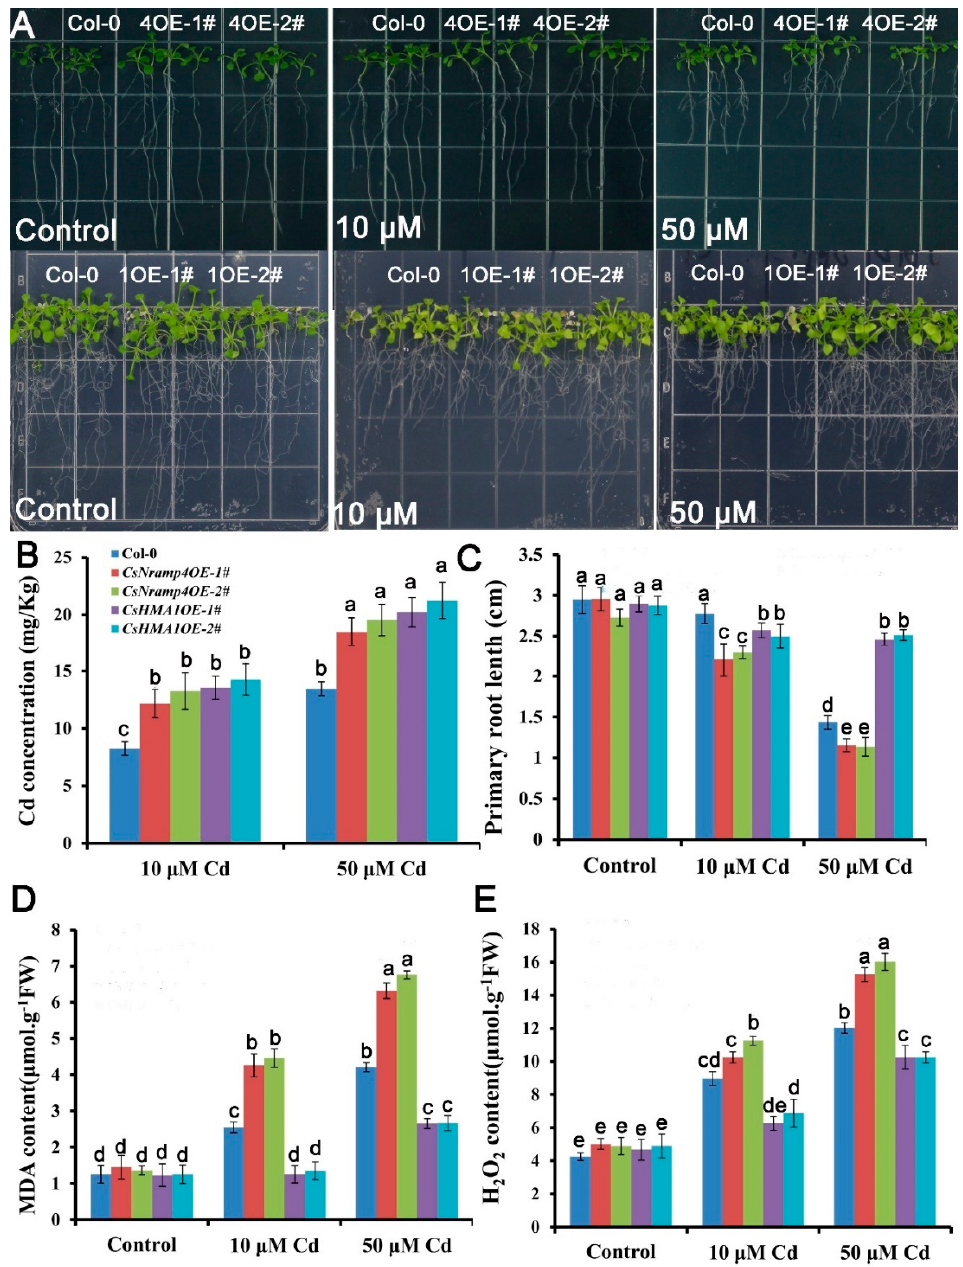
Figure 8. Analysis of Cd tolerance in the wild type (WT), CsNramp4 transgenic lines ( UBI10:CsNramp4 ), and CsHMA1 transgenic lines ( UBI10:CsHMA1 ) of Arabidopsis. ( A ) Phenotype of seedlings grown on 1/2 MS medium with or without 10 or 50 µ M Cd for 12 d. ( B ) Primary root length of UBI10:CsNramp4 and UBI10:CsHMA1 transgenic seedlings grown on 1/2 MS medium with or without10 and 50 μ M Cd for 12 d. ( C ) Cd concentrations in the shoots and roots of WT, UBI10:CsNramp4 and UBI10:CsHMA1 plants. ( D , E ) MDA ( D ) and H 2 O 2 ( E ) contents of WT, UBI10:CsNramp4 , and UBI10:CsHMA1 transgenic seedlings. Seedlings were grown on 1/2 MS medium with or without 10 or 50 μ M Cd for 48 h. Vertical bars represent standard deviation. Different letters on the bars indicate that the mean values are significantly different between the transgenic plants and wild-type plants ( p < 0.05).